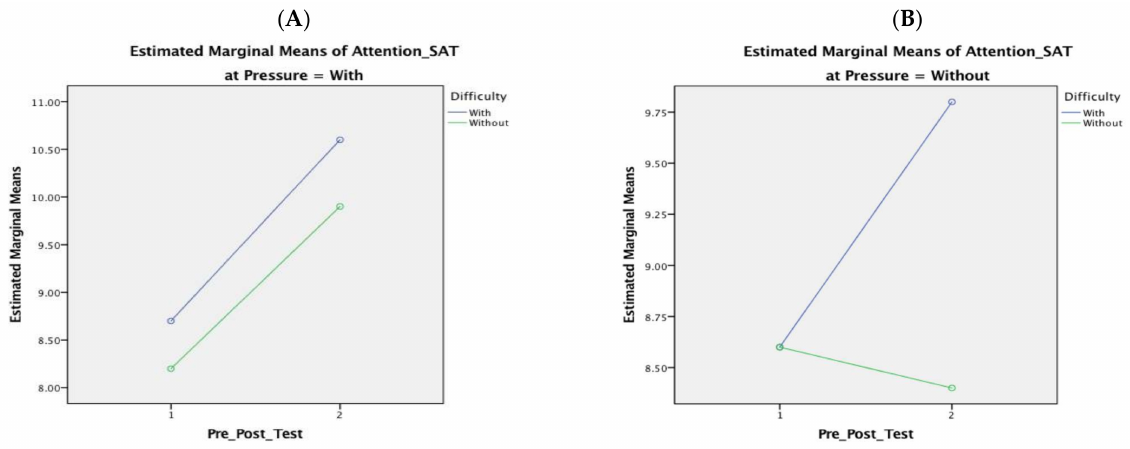
Figure 9. The graph of three-factor interaction in SAT. Figure ( A ) shows the interaction of pre/post- test * difficulty with pressure condition; Figure ( B ) shows the interaction of pre/post-test * difficulty without pressure condition. Note: pre/post-test (the horizontal axis), pre-test = 1, and post-test = 2.